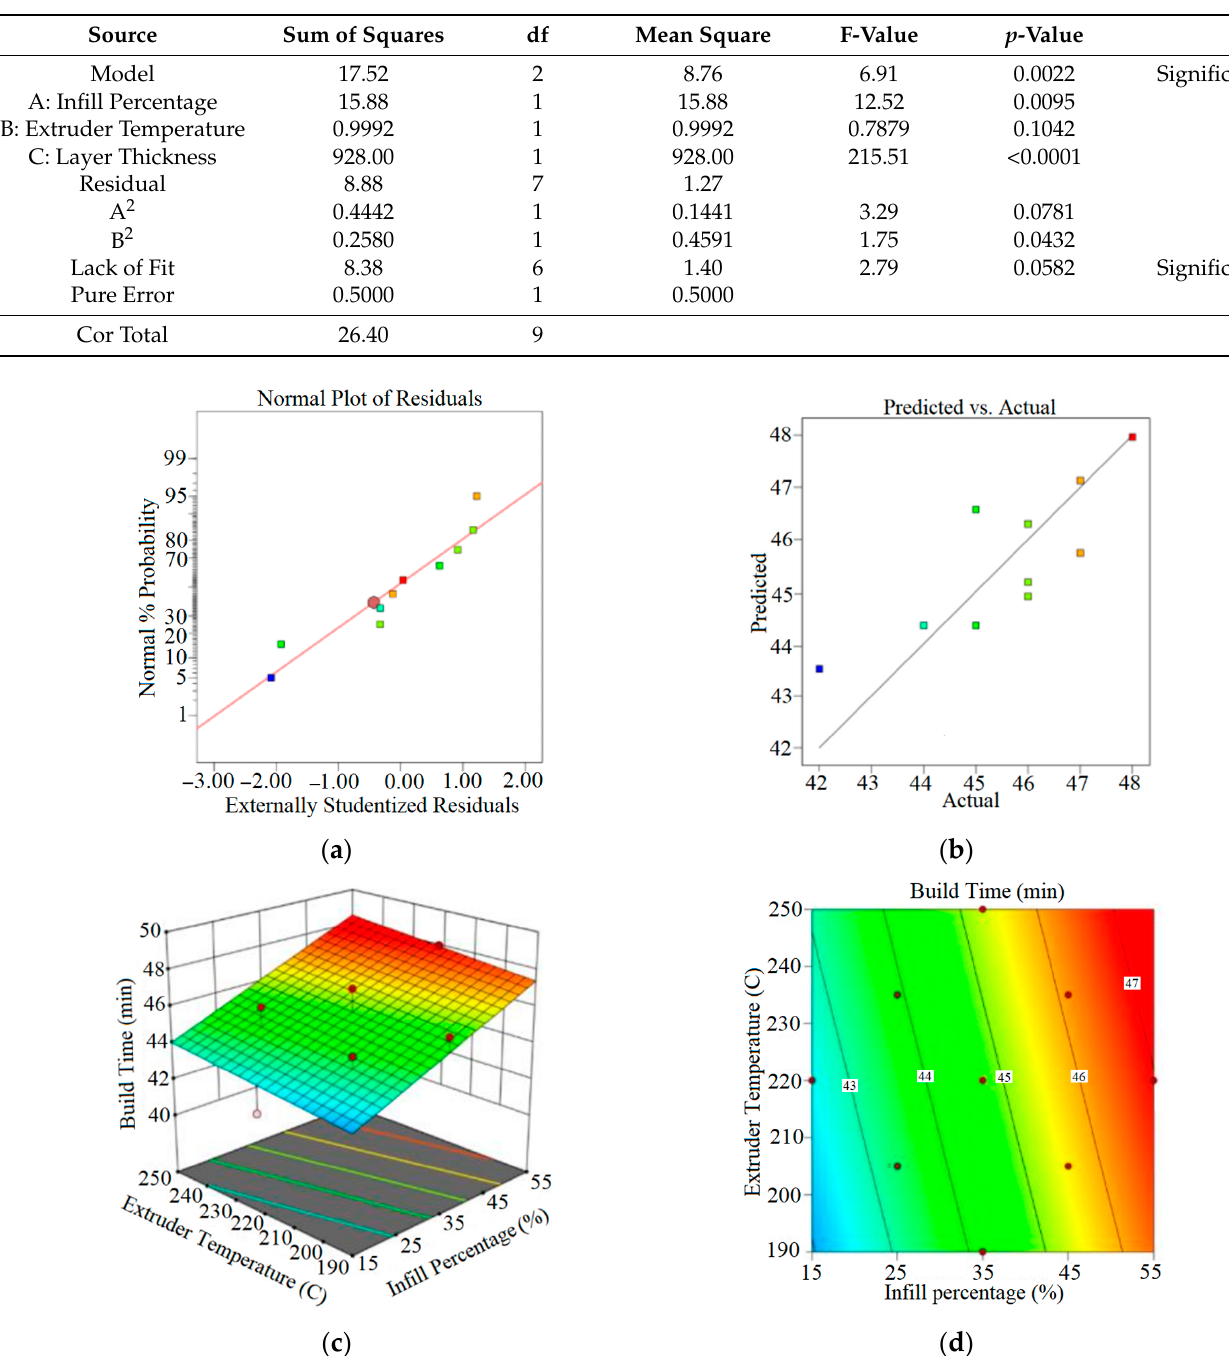
Table 7. Analysis of variance (ANOVA) for SW.